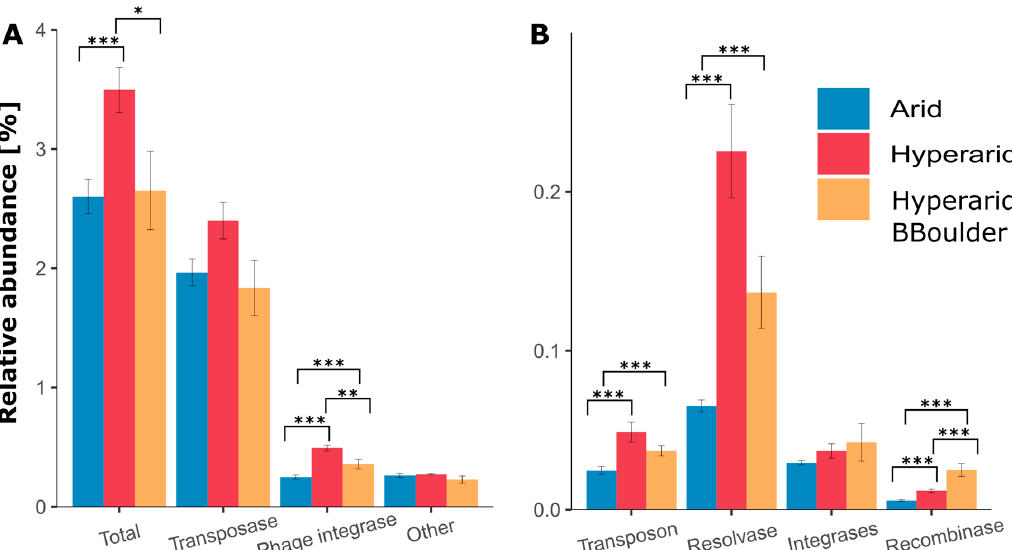
Figure 2. The relative abundance and diversity of ( A ) high abundant and ( B ) low abundant mobile genetic elements (MGEs) in di ff erent locations of the Atacama Desert. The standard error is shown, n = 4, 5 and 3 at Arid, Hyperarid and Hyperarid-BBoulder sites, respectively. Robust ANOVA, * < 0.05, ** < 0.005 and *** < 0.0005. Other: DDE (super family endonuclease) and DUF (domain of unknown function) elements related to